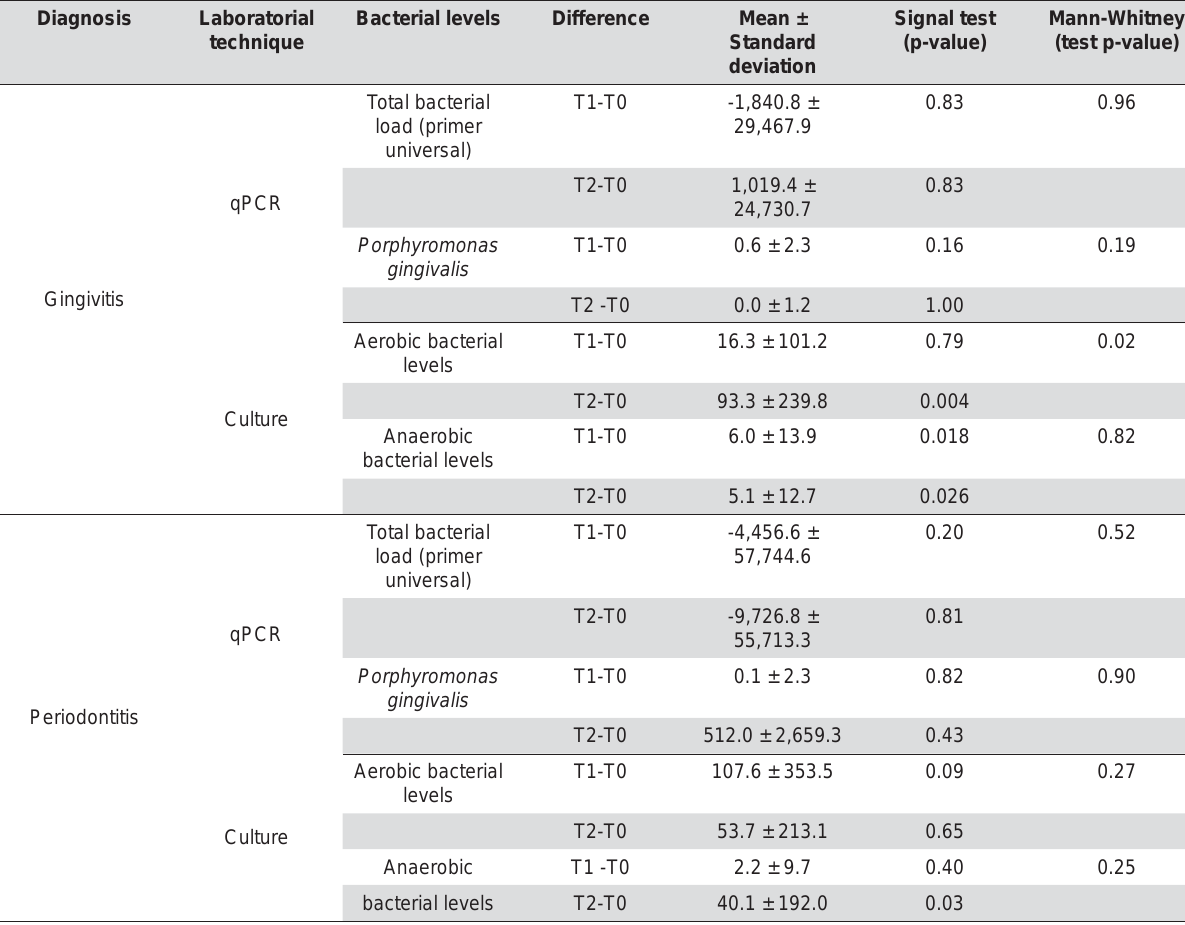
Table 3- Mean difference between time samplings (T1–T0) and (T2–T0) for all monitored bacterial levels according to periodontal diagnosis and laboratorial